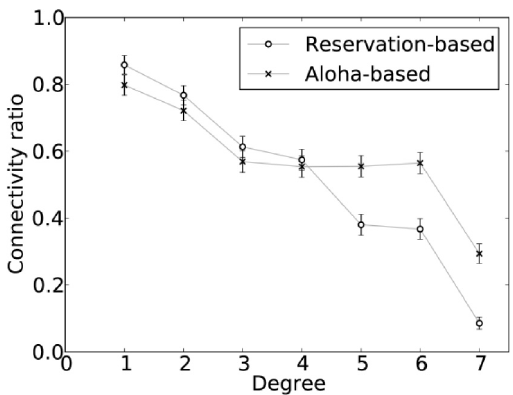
Figure 6. Mean connectivity ratio by degree for unidirectional links: experimental